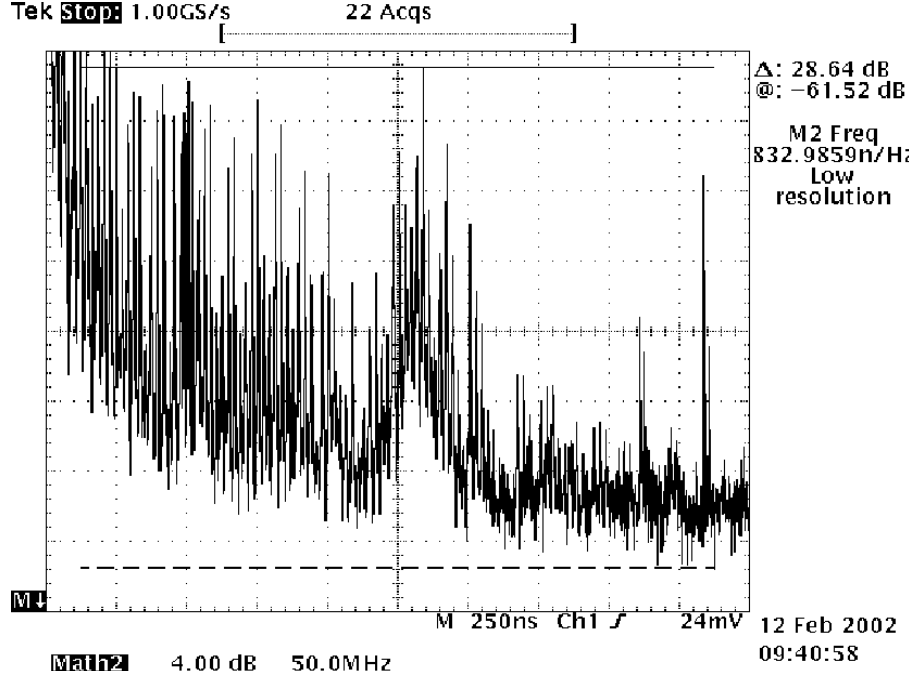
Figure 3. FFT of an output signal from 74HC245 logic